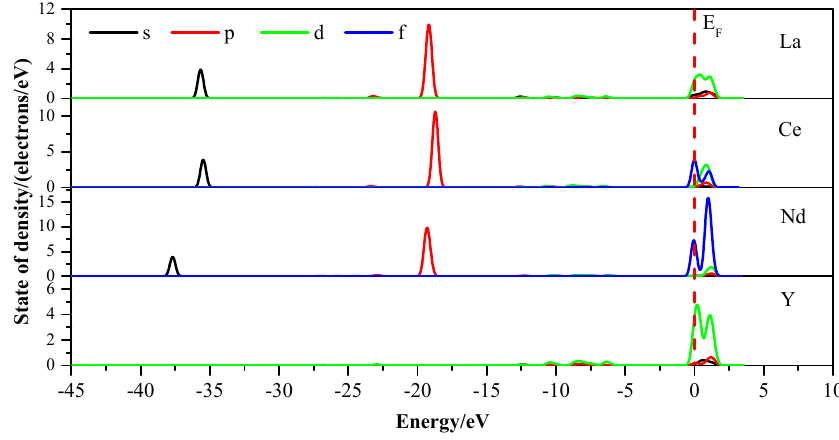
Figure 6. Partial density of state (PDOS) of rare earth atoms in REE-FAP crystals.